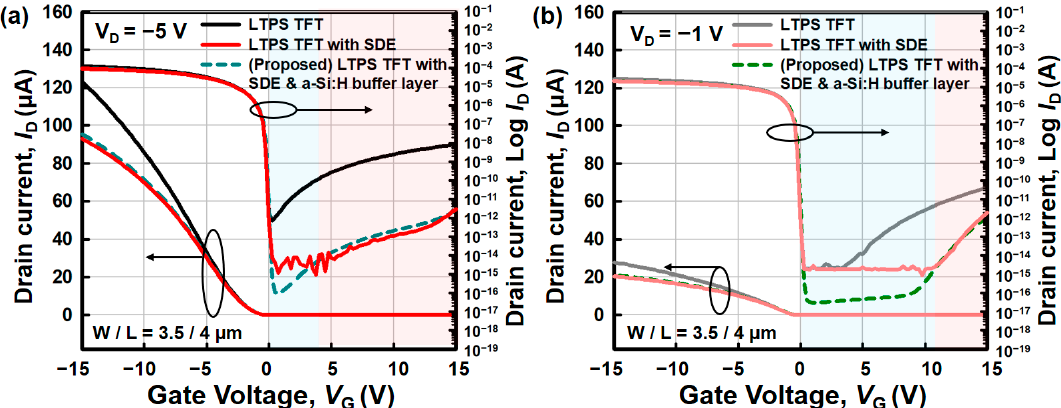
Figure 4. Linear scale (left Y -axis) and log scale (right Y -axis) transfer ( I D - V G ) curves of a conventional LTPS TFT, LTPS TFT with SDE, and the proposed LTPS TFT with SDE and amorphous silicon buffer layer: ( a ) at V D = − 5 V; and ( b ) at V D = − 1 V. The blue (red) background are the areas where the thermal (field-enhanced) generation mechanism is dominant.